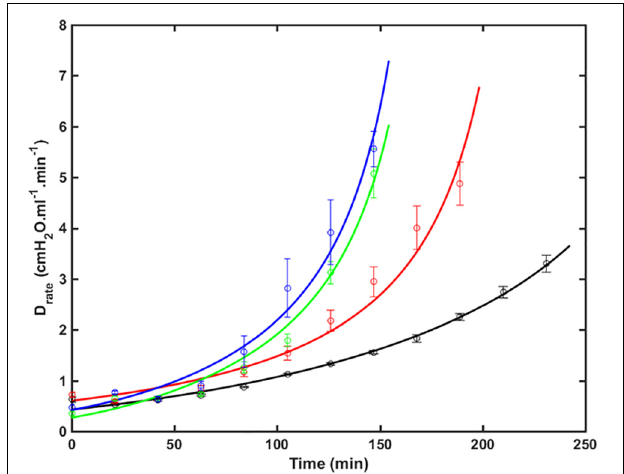
FIGURE 1 | D rate (average ± SE) versus time as VILI developed in the 4 groups of mice (symbols) together with the model fits to Eq. 9 (lines). Black: V t = 1.0 ml (RMSE = 0.35); Red: V t = 1.1 ml (RMSE = 0.64); Green: V t = 1.2 ml (RMSE = 0.36); Blue: V t = 1.3 ml (RMSE = 0.65). The data were collected in a previous study (Smith et al., 2013) (RMSE – root mean squared